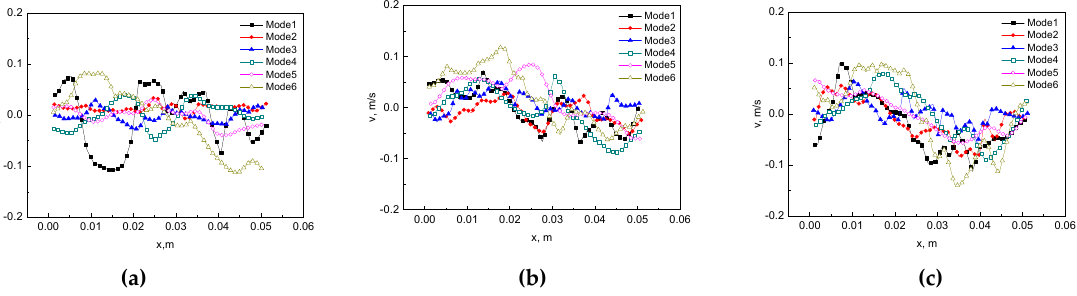
Figure 11. The horizontal component of velocity at 1 mm below the liquid surface in three physical forms of the hydraulic jump (casting speed 2.4 m/min). ( a ) CHJ. ( b ) HJT. ( c ) SLL.